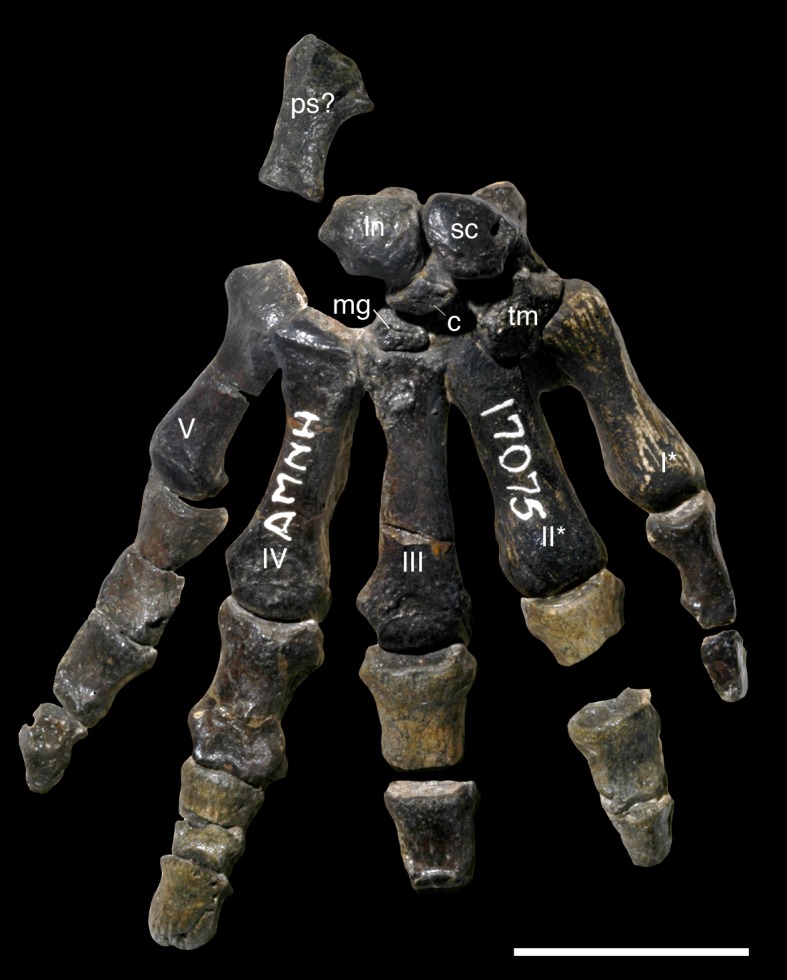
Right manus of Periptychus carinidens (AMNH 17075) in dorsal view.Abbreviations: c, centrale; ln, lunate, mg, magnum, ps, pisiform, sc, scaphoid, tm, trapezium; I-V refer to digit number; * denotes reconstructed elements. Scale bar: 30mm. Note that this specimen is reconstructed and mounted on a resin base. Photographs of the individual bones are illustrated and photographed in [5].